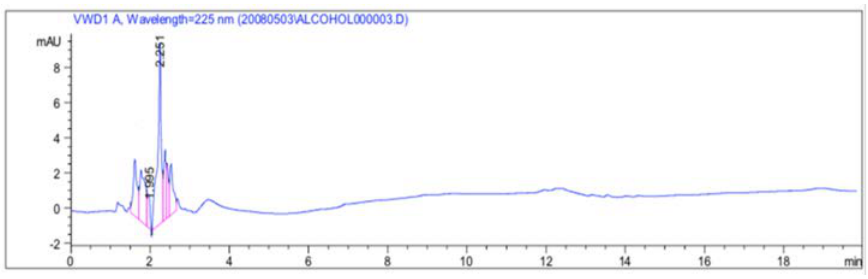
Figure 3. Chromatogram, HPLC, of a real Ouzo sample, to check the specificity of the